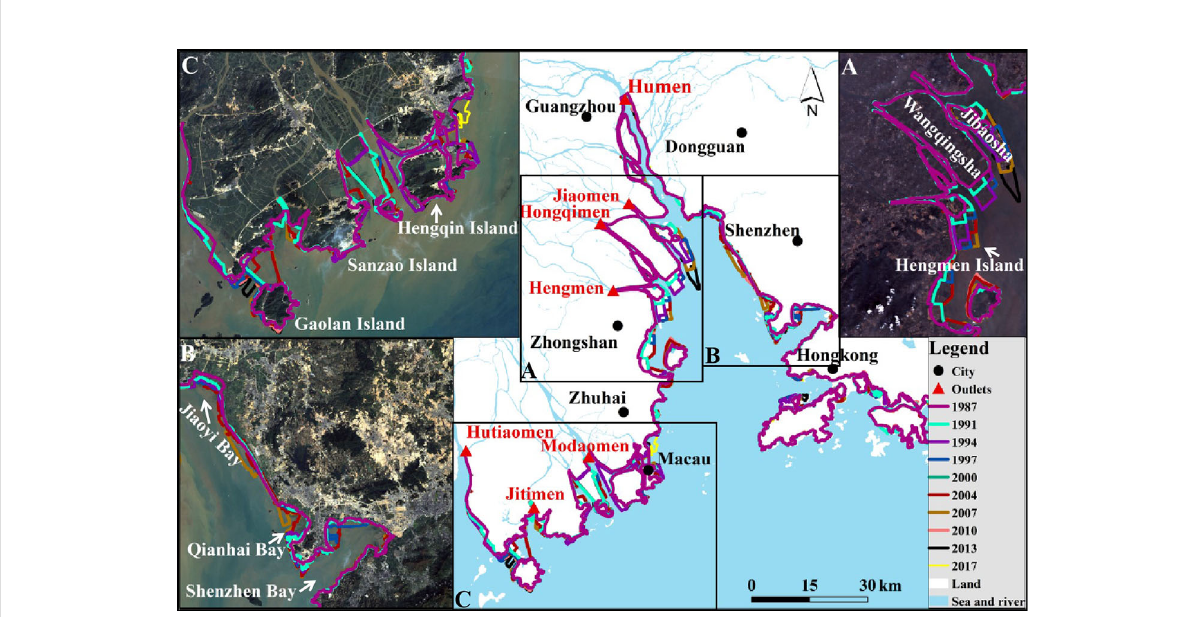
FIGURE 3 The spatiotemporal variation of coastline locations from 1987 to 2017: (A) from the Jiaomen Outlet to the Hengmen Outlet in the western part of the study area, (B) from the Jiaoyi Bay to the Shenzhen Bay in the eastern part of the study area, and (C) from the Modaomen Outlet to the Jitimen Outlet in the western part of the study area.